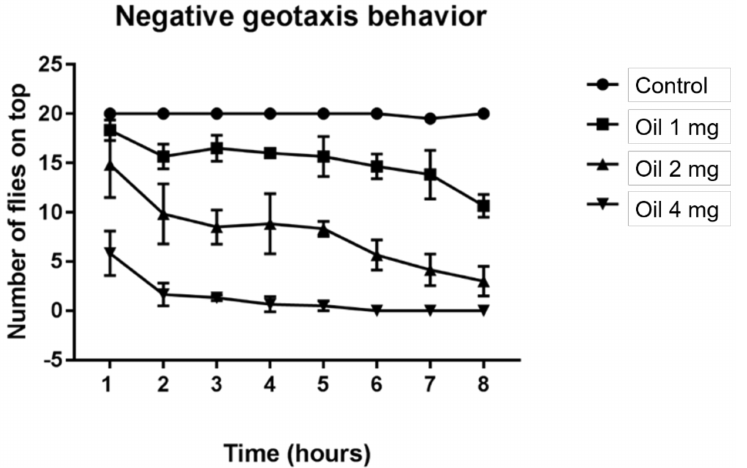
Figure 6. Effect of the D. ambrosioides leaf essential oil on the locomotor ability of D. melanogaster . Subtitles: Locomotor activity was determined by negative geotaxis behavior. Results are expressed as the mean ± SD of the number of flies able to climb a marked glass column, as previously described, during each exposure